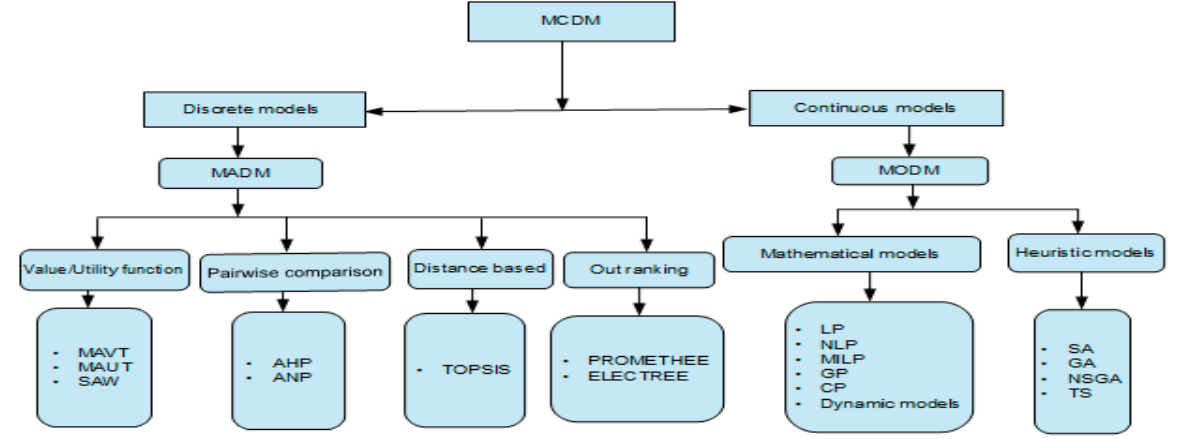
Figure 1. Classification of multi-criteria decision-making (MCDM) methods.